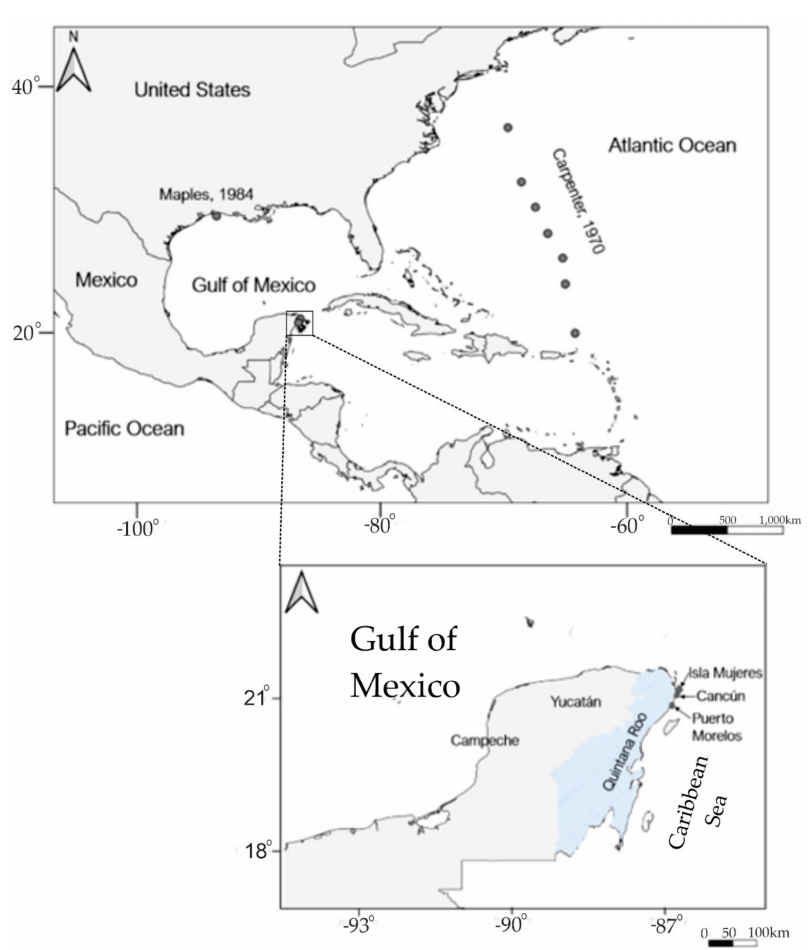
Figure 1. Location of sampling sites of Sargassum fluitans and S . natans on the Mexican’s Caribbean coast and previous